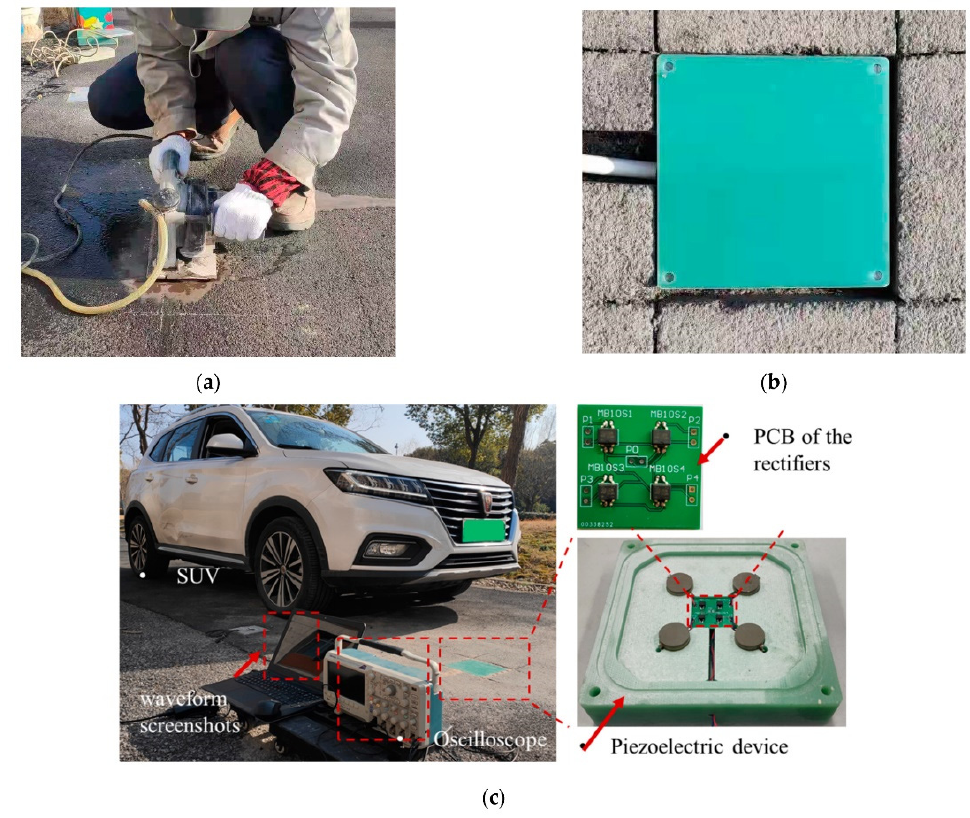
Figure 7. On-site tests of the piezoelectric device: ( a ) cutting the pavement surface, ( b ) installing the PEH, and ( c ) applying vehicle load. Adopted from [78].